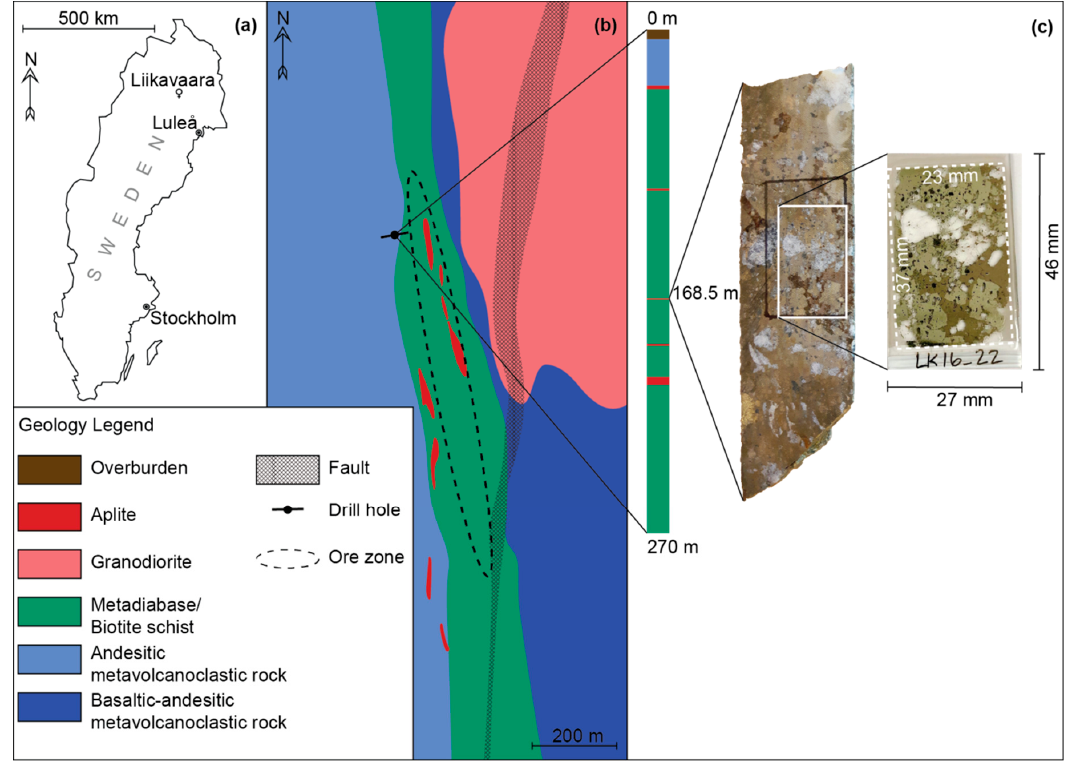
Figure 1. ( a ) Location of the Liikavaara Cu-(W-Au) deposit in Northern Sweden; ( b ) geological map of the Liikavaara deposit at 100m below surface. Location of the drill hole for the sample analyzed in this study is shown; ( c ) thin section prepared from a drill core intersecting a mineralized quartz vein within an aplite dike. Modified from Warlo et al. [ 16 ].